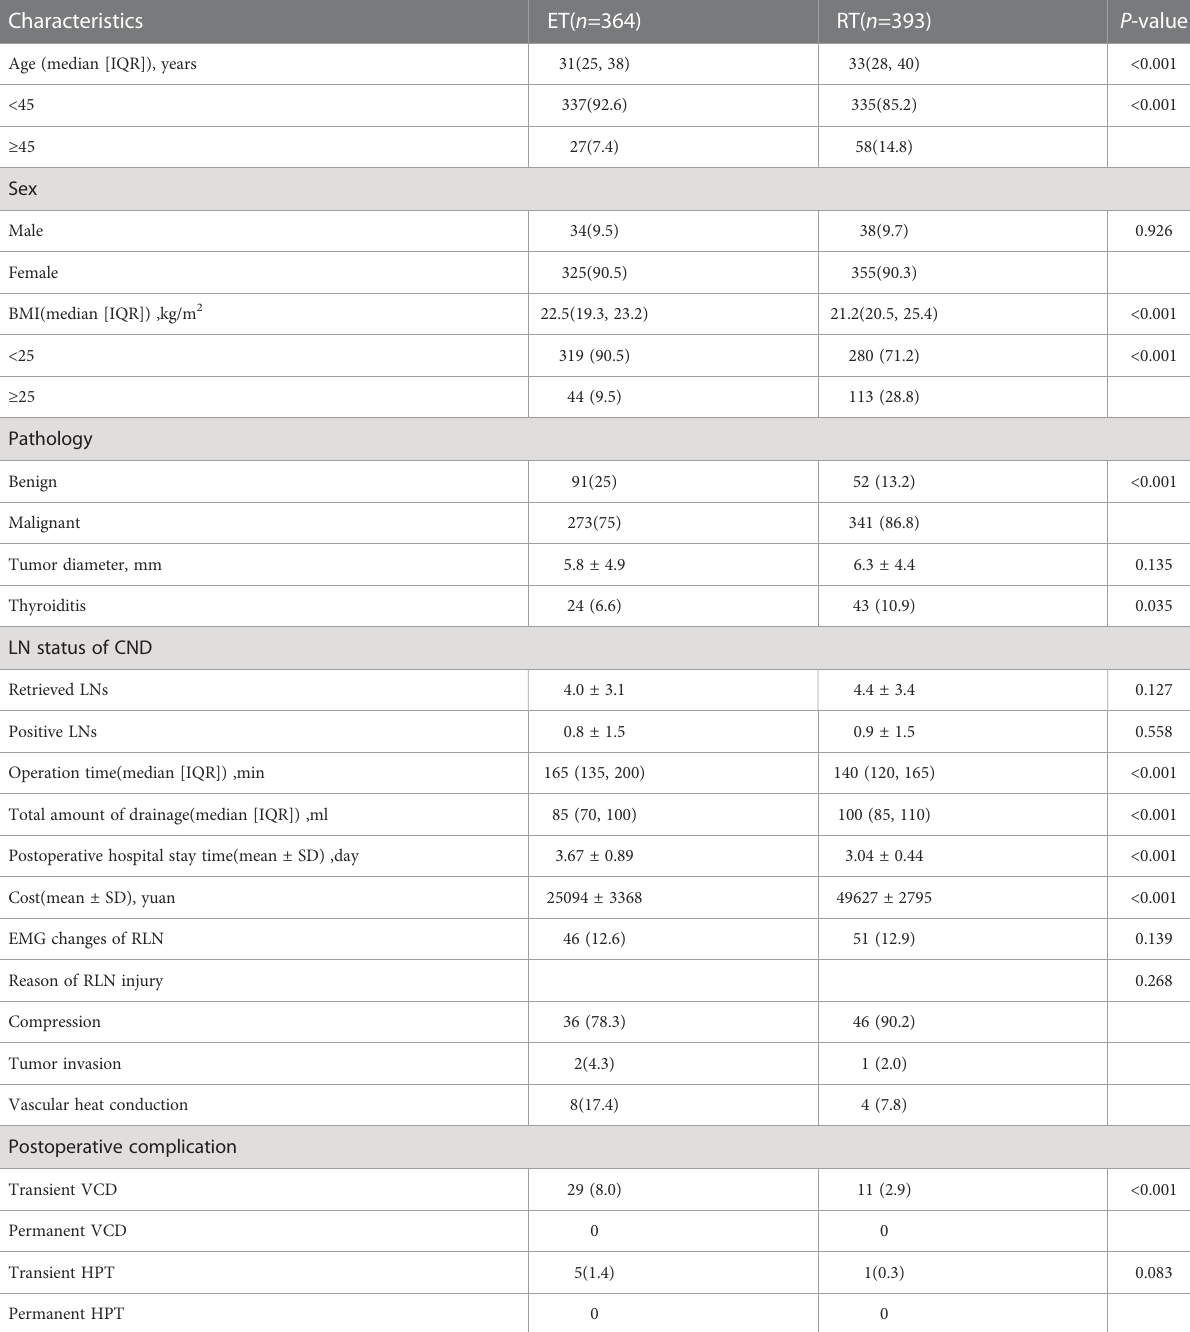
TABLE 3 Demographics, pathological characteristics and Perioperative outcomes of patients.